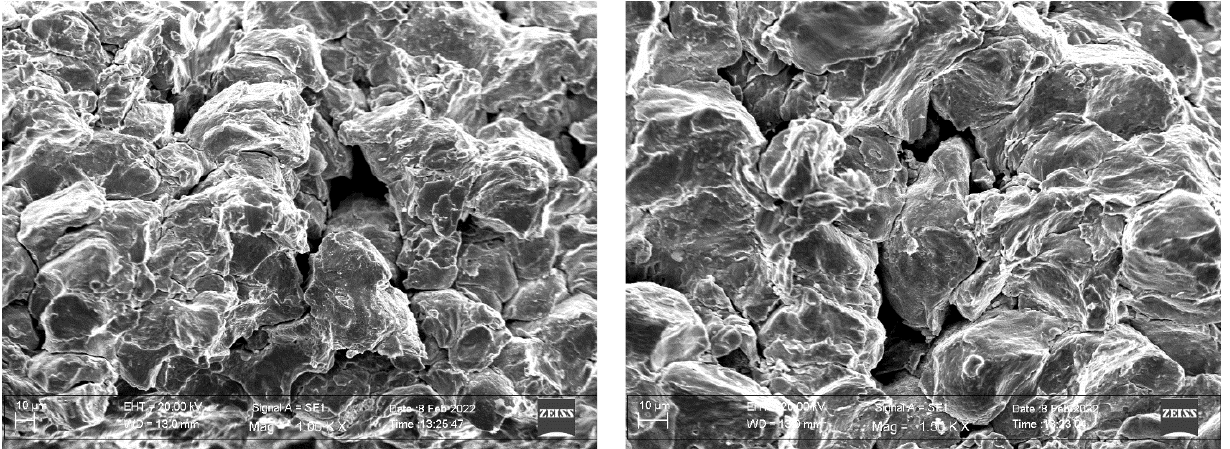
Figure 16. Voids at the particle – particle interface for the notched sample tested at the maximum stroke of 1.8 mm.